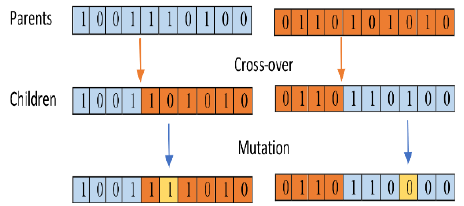
Figure 1. The figure demonstrates genetic algorithm operators.